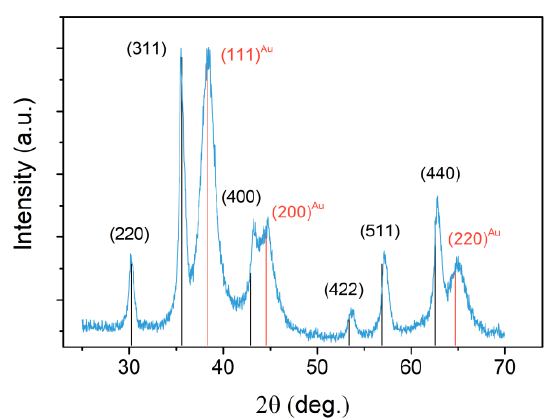
Figure 2. X-Ray Diffraction (XRD) pattern of Fe 3 O 4 -Au nanoparticles (NPs) (blue line) and reference patterns of magnetite (black bars; JCPDS 04-007-2718) and gold (red bars; JCPDS 00-004-0784).